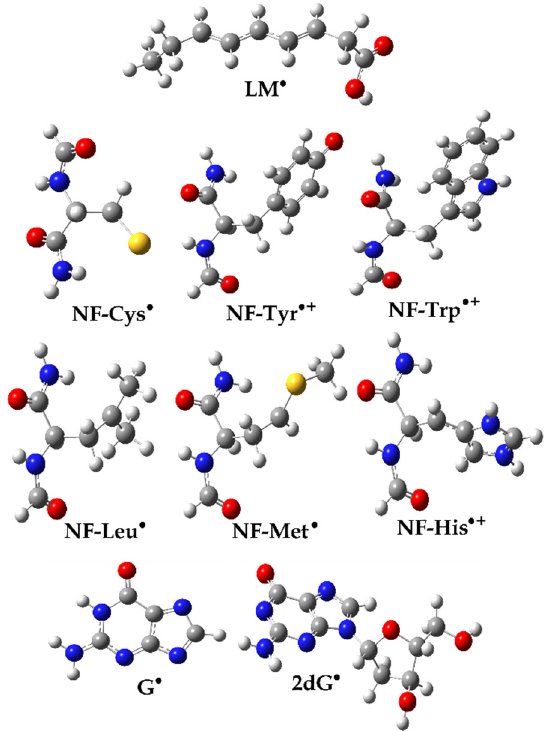
Figure 7. Optimized geometries of selected radicals/radical cations of biomolecular target com- pounds in water at M06-2X/6-311++G(d,p) level of theory.